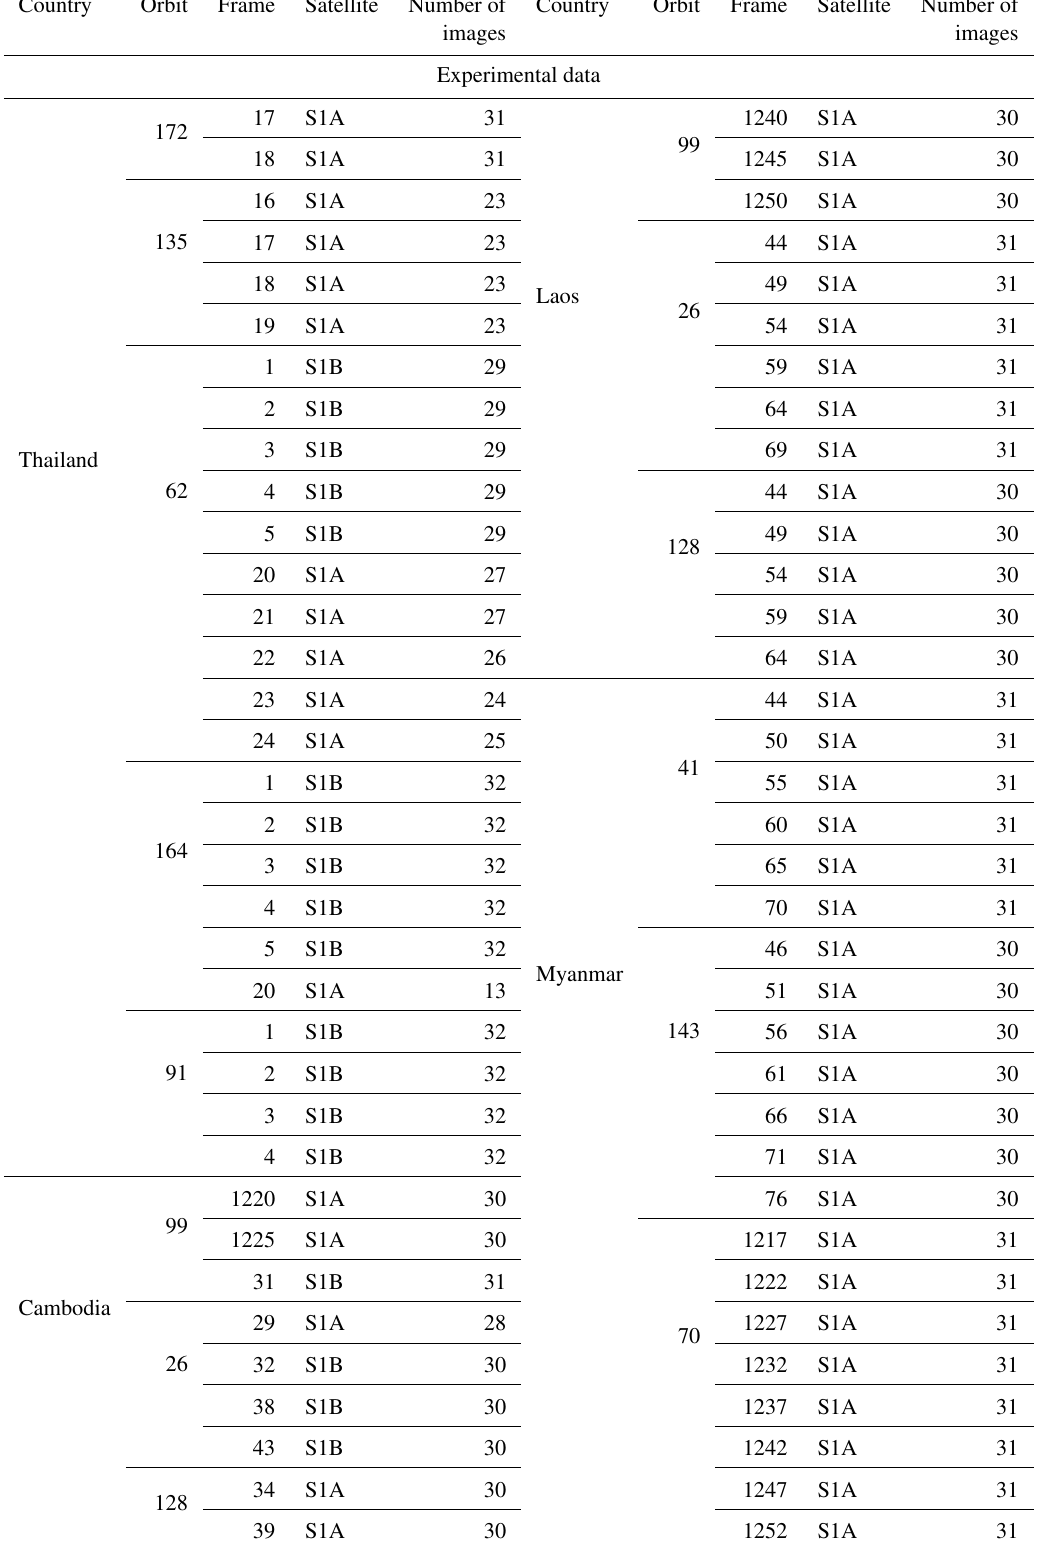
Table 1. List of Sentinel-1 SAR data in 2019 used in this study. Country Orbit Frame Satellite Number of Country Orbit Frame Satellite Number of images images Experimental data